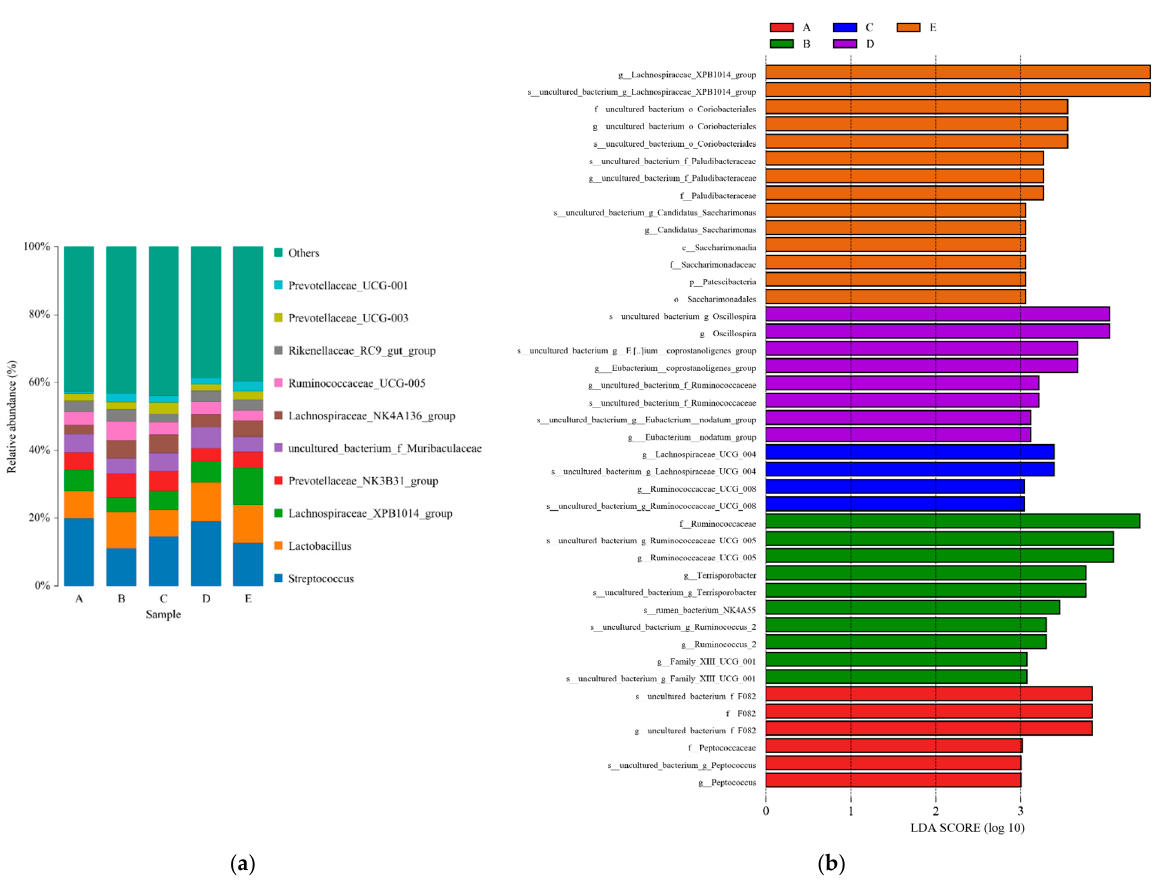
Figure 3. Microbiota composition at genus level ( a ) and linear discriminant analysis effect size analysis (LEfSe) ( b ) of the colon communities of individual pigs after feeding control diet (A, CON), low protein diet (B, LP), LP + sodium dichloroacetate diet (C, LP + DCA), LP + sodium dichloroacetate diet (D, LP + GLUC), and LP + DCA + GLUC diet (E), respectively. n = 5. LEfSe analysis (LDA > 3), showing the most differentially abundant taxa enriched in microbiota from pigs. Table 5. Effects of supplementing low protein (LP) diets with sodium dichloroacetate (DCA) and glucose (GLUC) on colonic microbiota composition at genus level (Top 10) in growing ‐ finishing pigs.